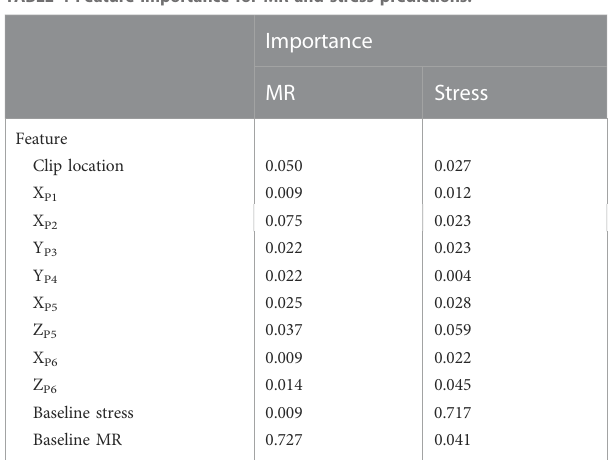
TABLE 4 Feature importance for MR and stress